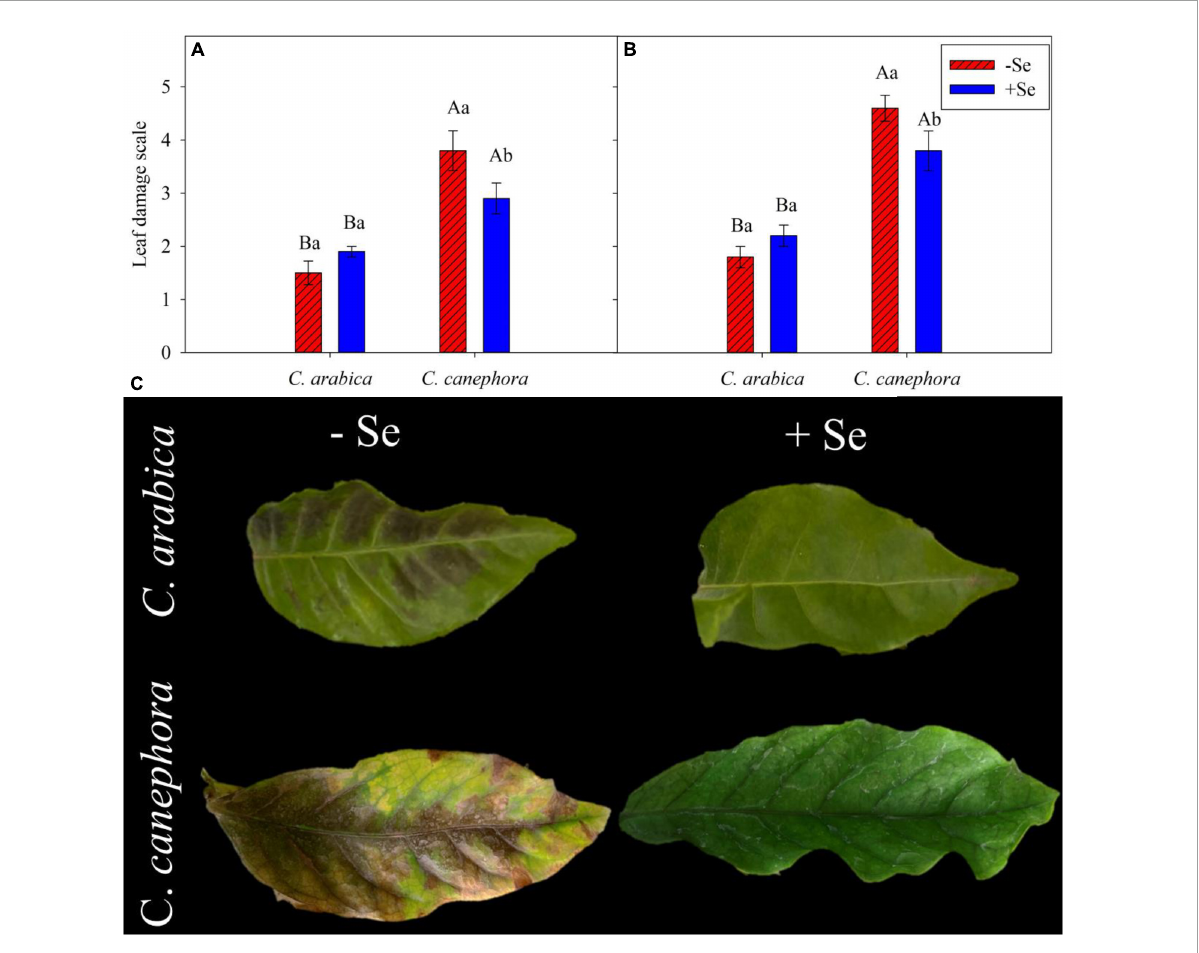
FIGURE1 Leaf visual damage in coffee species exposed to chilling stress and two conditions of Se foliar supply after 2 days of exposure to low temperature. Visual damage scale during (A) and after stress (B) according to Manetti Filho and Caramori (1986). (C) Visual damage in coffee after low-temperature stress. Mean values followed by different lowercase letters within Se supply conditions (with selenium and without Se) in each genotype and different uppercase letters indicate significant differences within each genotype ( C. arabica and C. canephora ) in each Se supply condition are significantly different ( p < 0.05, n = 5) by Tukey multiple comparison test. Vertical bars represent the standard